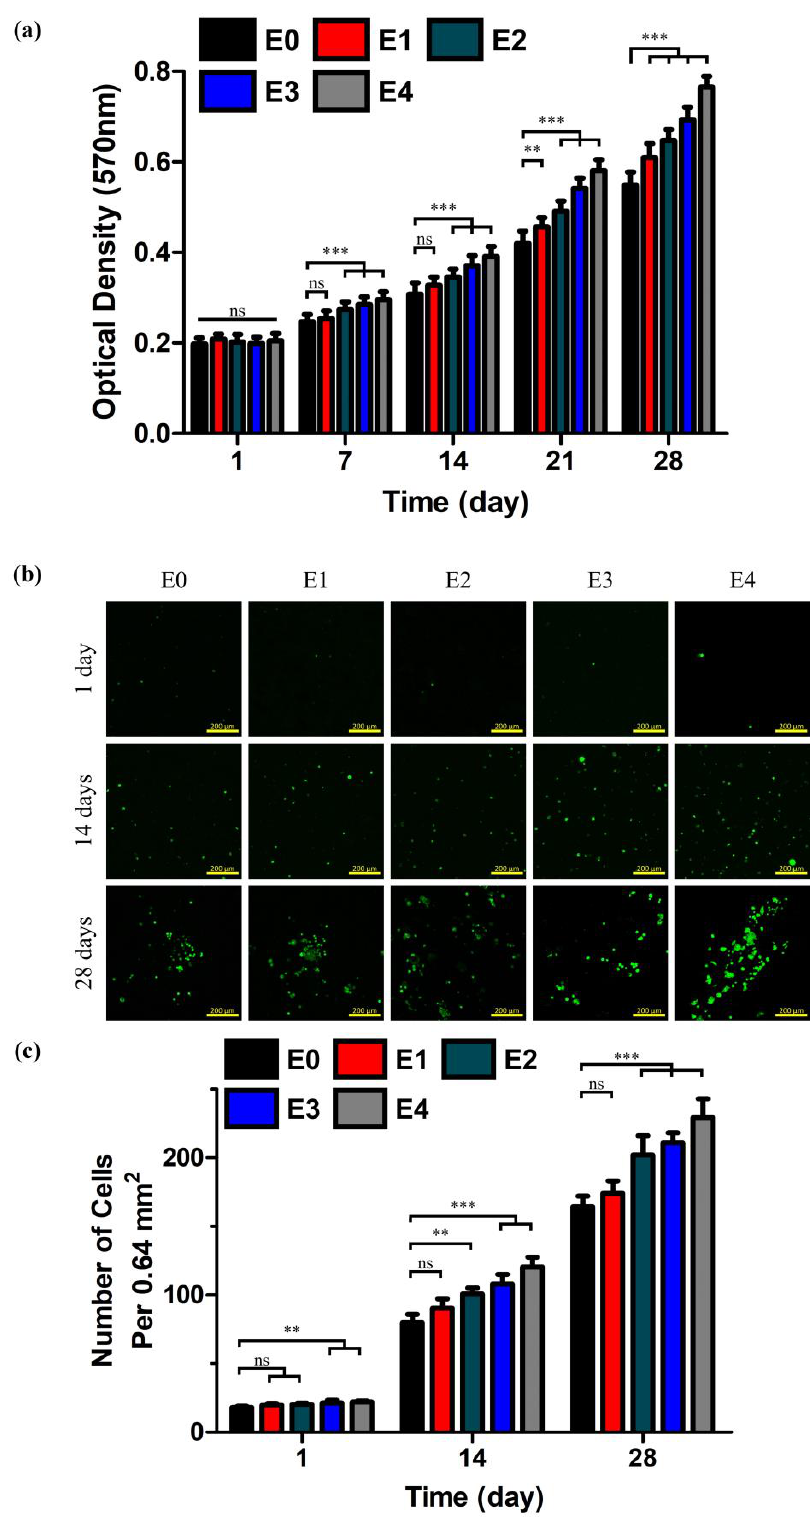
Figure 9. ( a ) Optical densities of formazan crystals measured at 570 nm in order to determine cell proliferation of pigment epithelium (RPE) cells cultured in the ESM / GG hydrogels based on a tetrazolium bromide (MTT) assay. CLSM images ( b ) and the number ( c ) of living cells cultured for 1, 14, and 28 days in the ESM / GG hydrogels containing di ff erent amounts of ESMs. p values were analyzed through the one-way ANOVA test and specified as follows: NS p < 0.05, ** p < 0.01, and *** p < 0.001. Error bars mean the standard deviation (n = 12 for the optical densities of formazan crystals and n = 4 for the number of living cells).